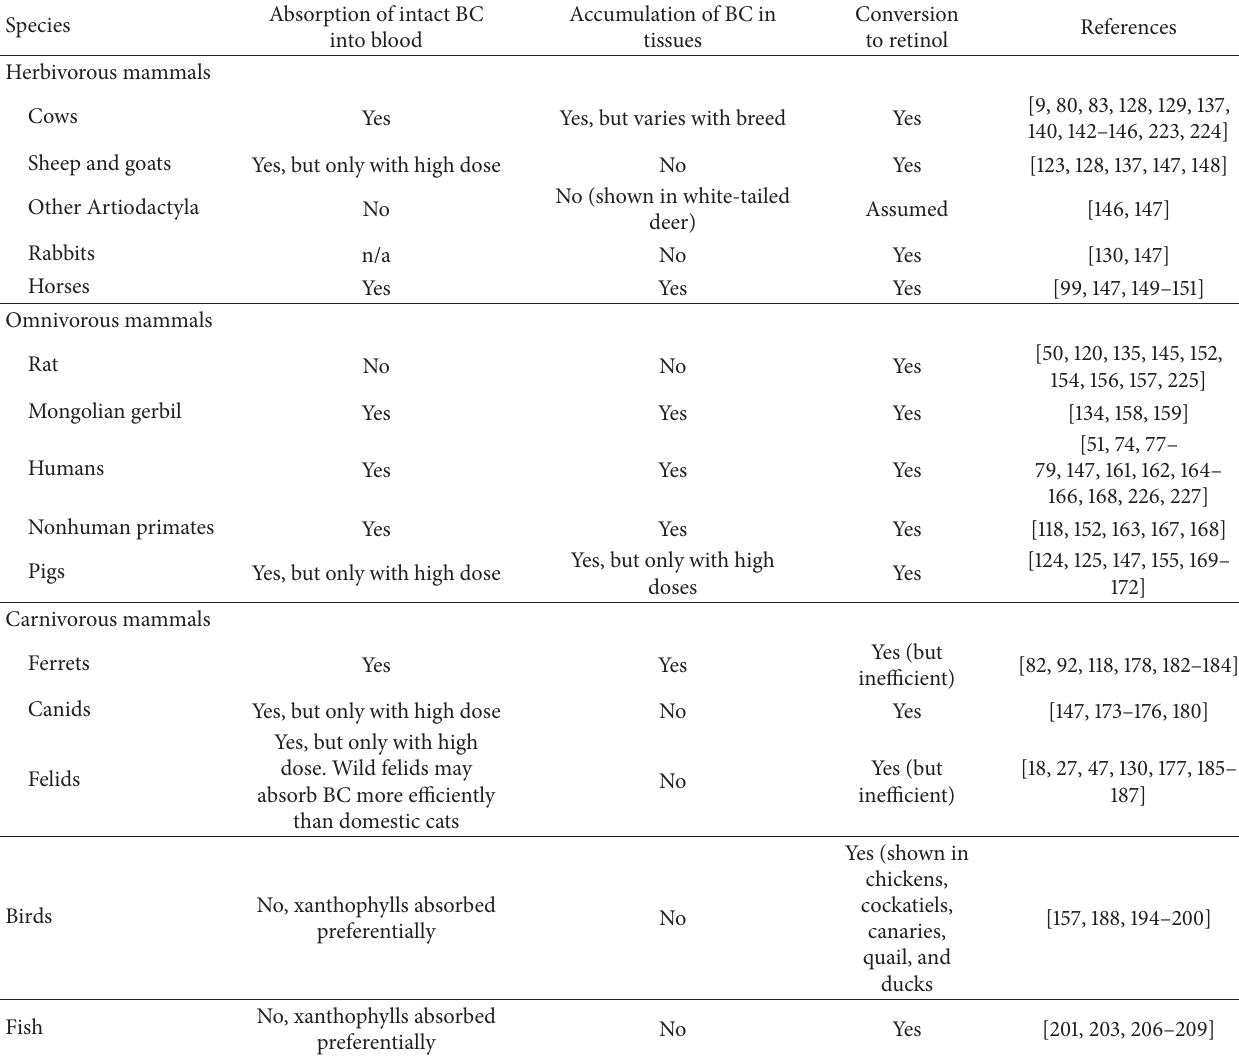
Table 3: Summary of 𝛽 -carotene metabolism in animal